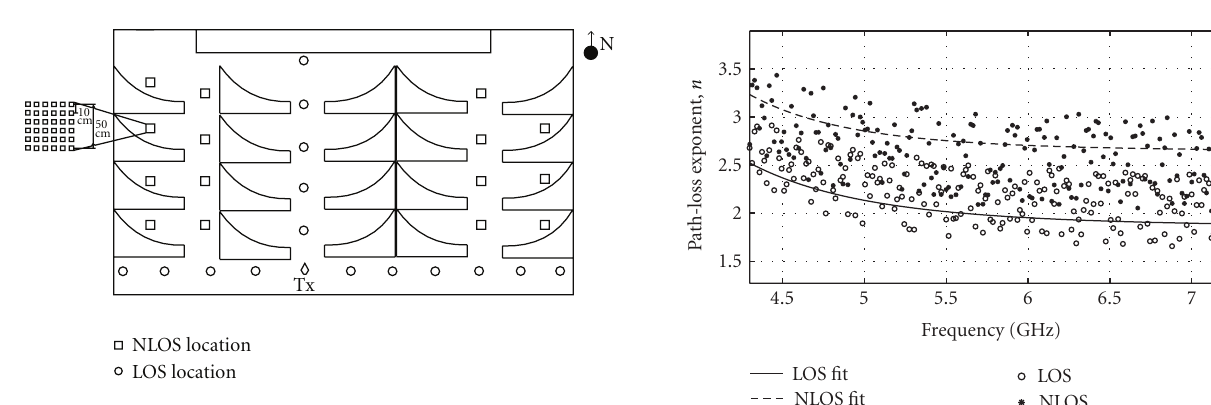
Figure 4: Scatter plots of path-loss exponent n and corresponding frequency. The curves are least squares regression fit to the formula f a 2 + a n = a 1 3